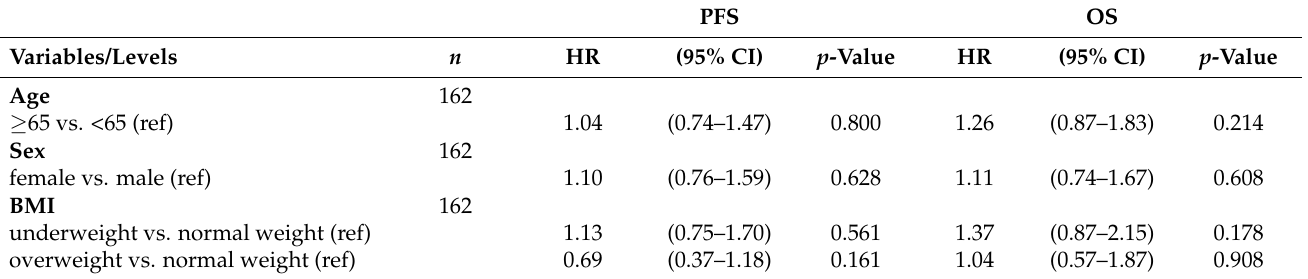
Table 3. Univariable Cox regression for PFS and OS of all patient characteristics and